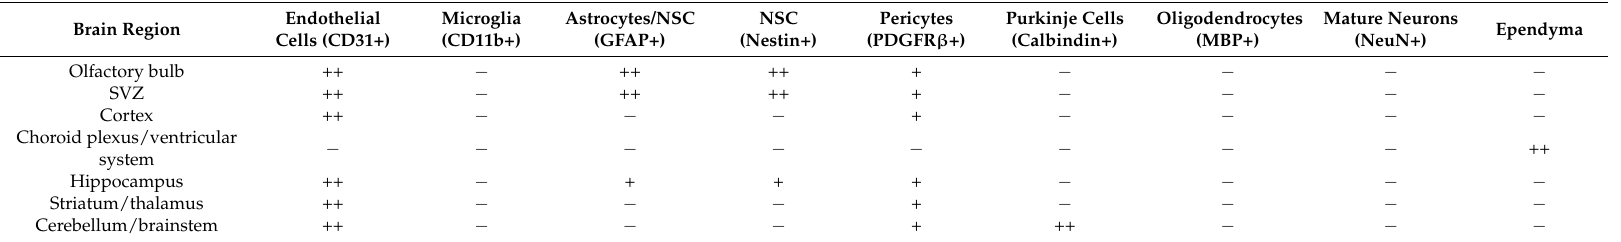
Table 1. Semi-quantitative assessment of TSPO immunoreactivity in various cell types of the brain by